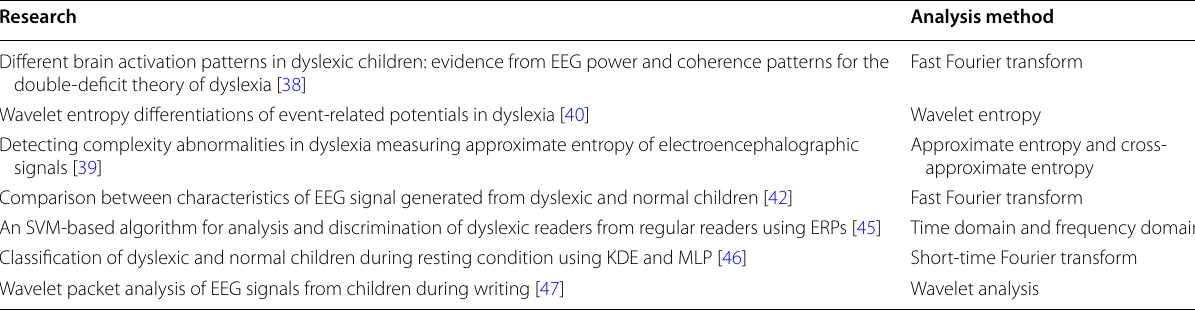
Table 7 Analysis summary